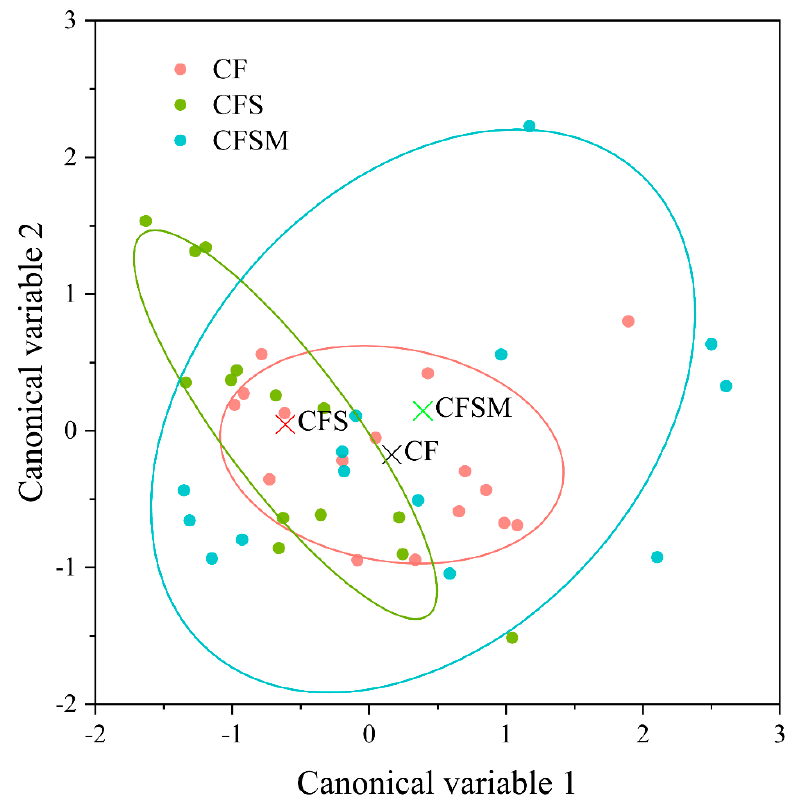
Figure 5. Canonical discriminant analysis of three treatments extracted from P leaching loss.